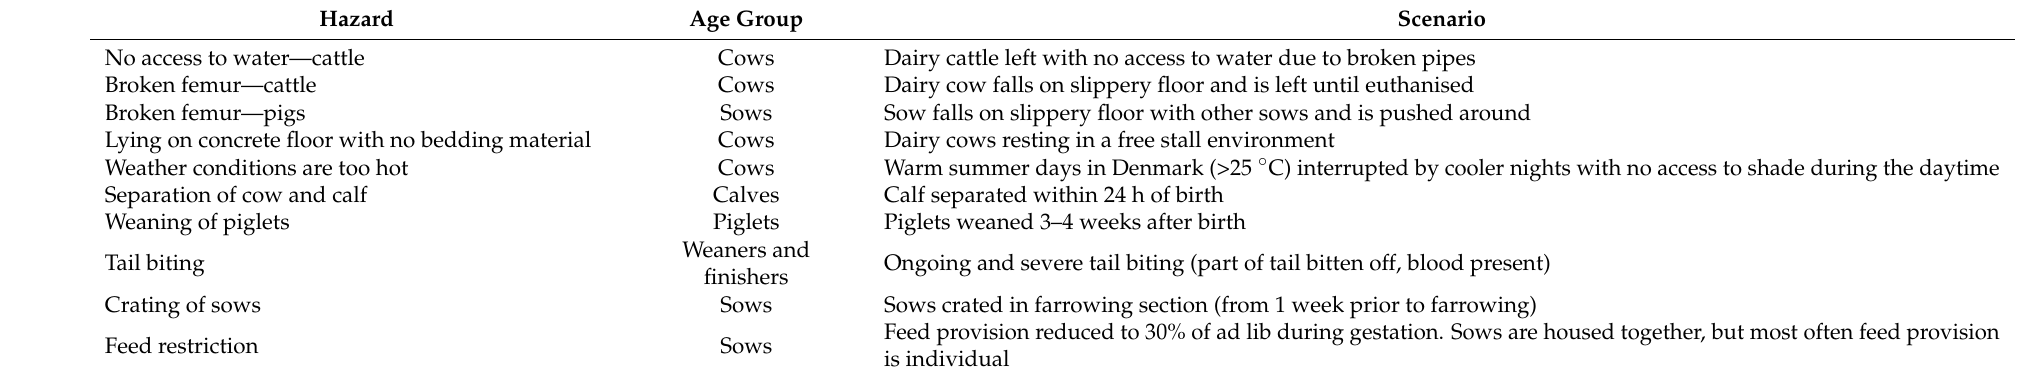
Table 2. Scenario description of ten welfare hazards occurring in dairy cattle and pig production used for